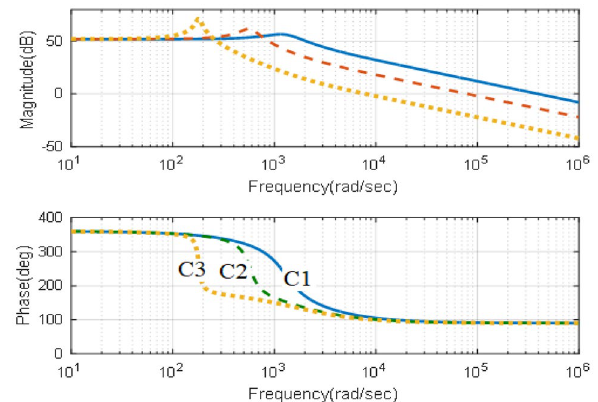
Figure 5. Effects of varying the inductance,